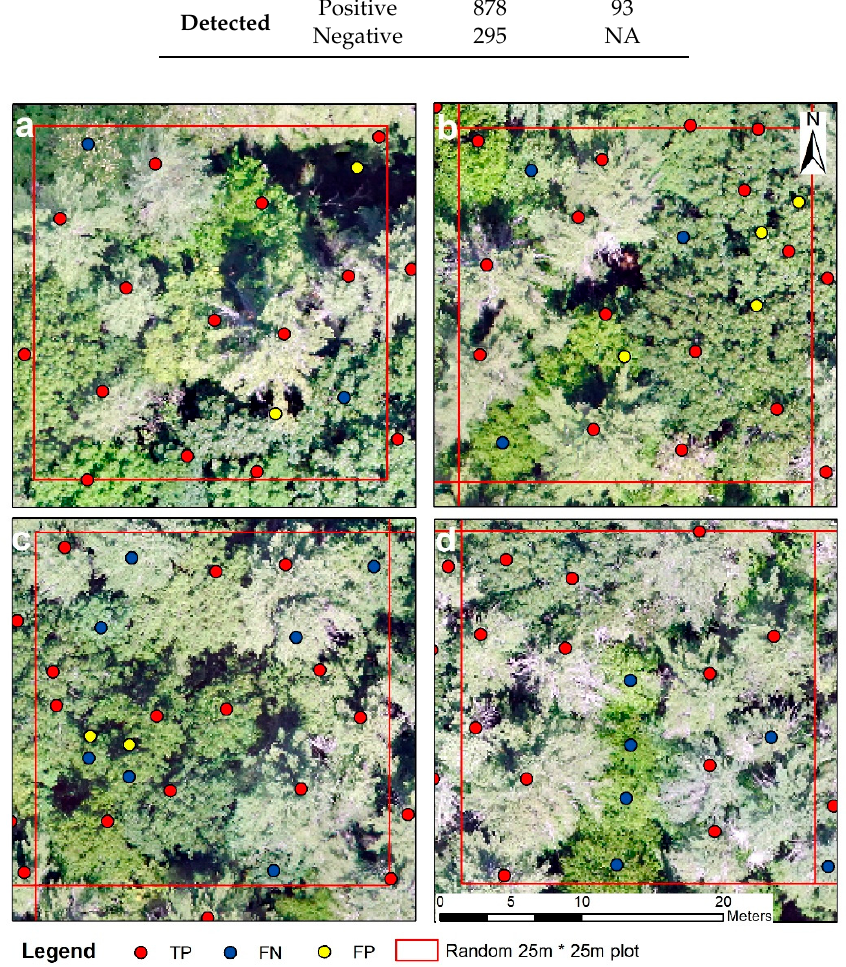
Figure 3. Examples of treetop detection: ( a – d ) are four examples of detected treetops showing TP, FN and FP.